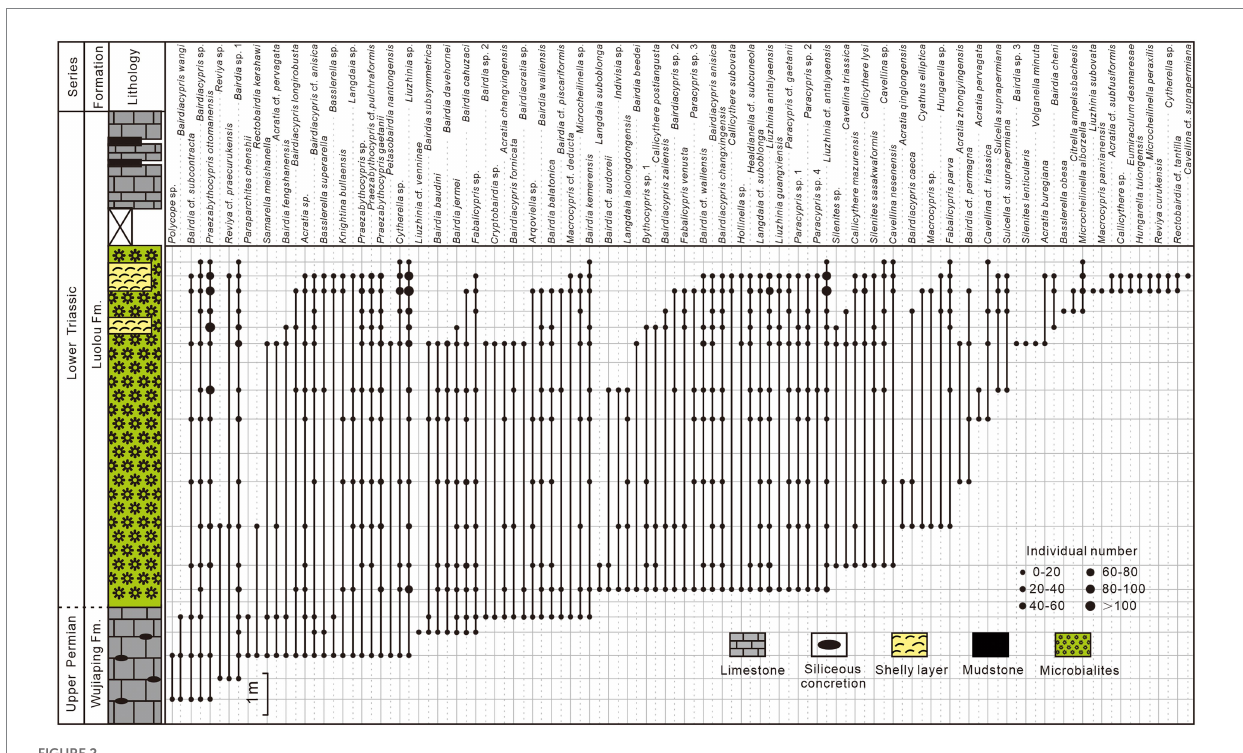
FIGURE 2 Distribution of ostracods fossils at the Youping